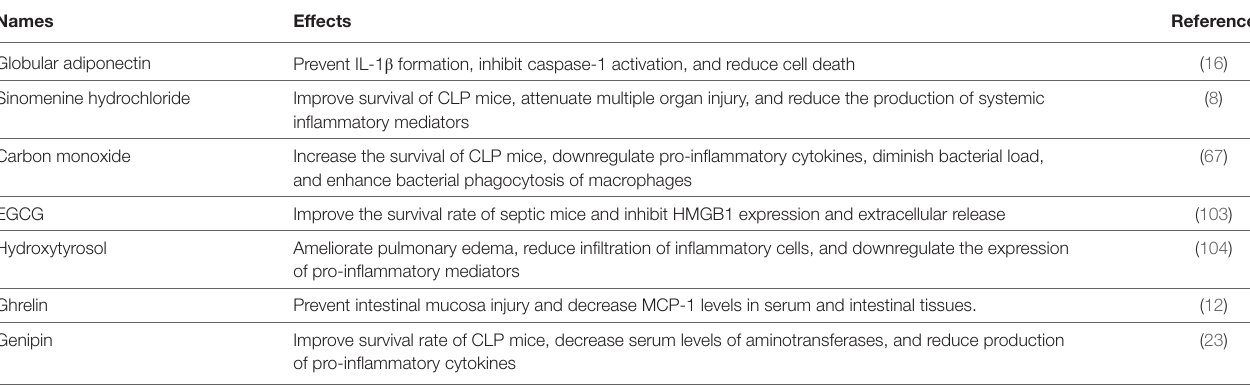
TABLe 1 | The effects of different drugs on sepsis by inducing